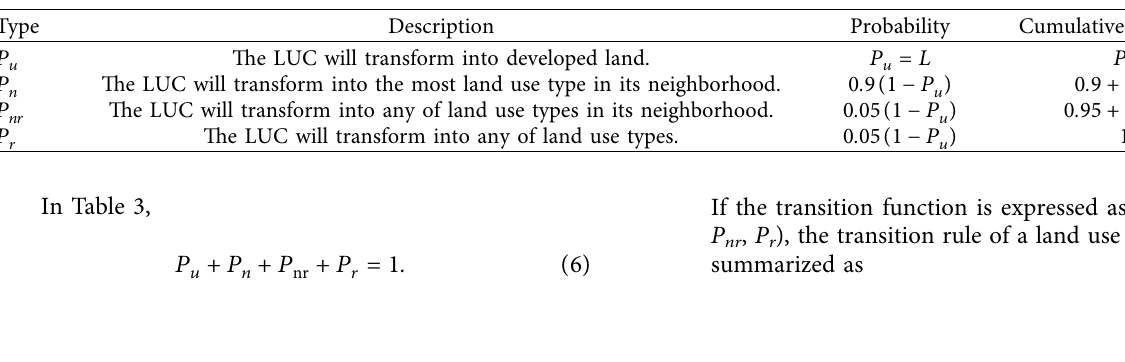
Table 3: The transition